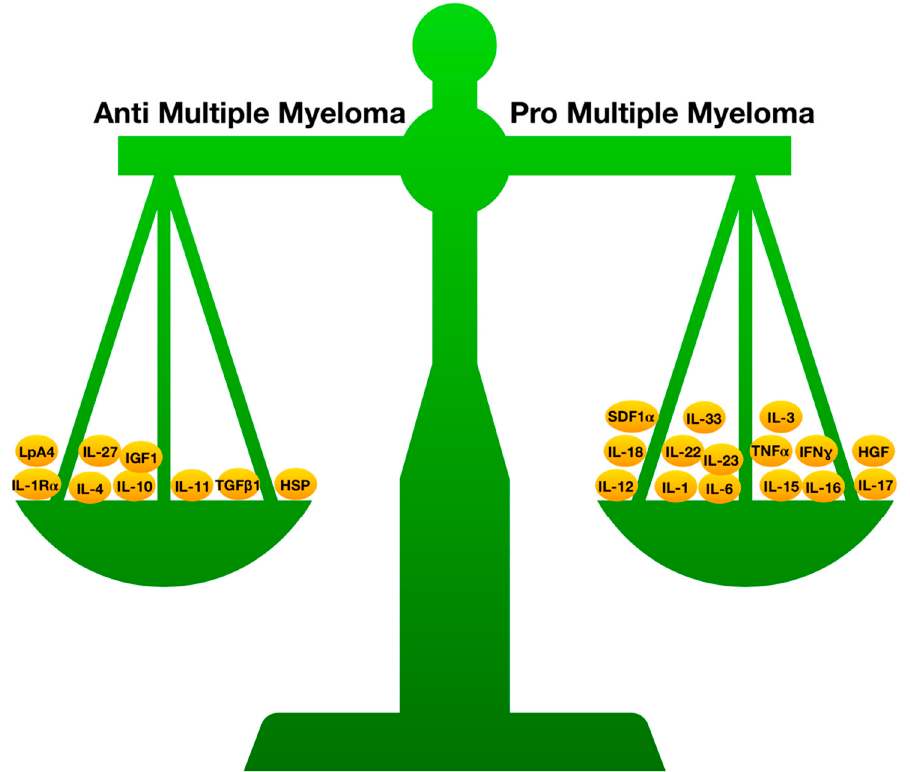
Figure 3. Balance of pro- and anti-inflammatory cytokines in multiple myeloma (MM) progression.